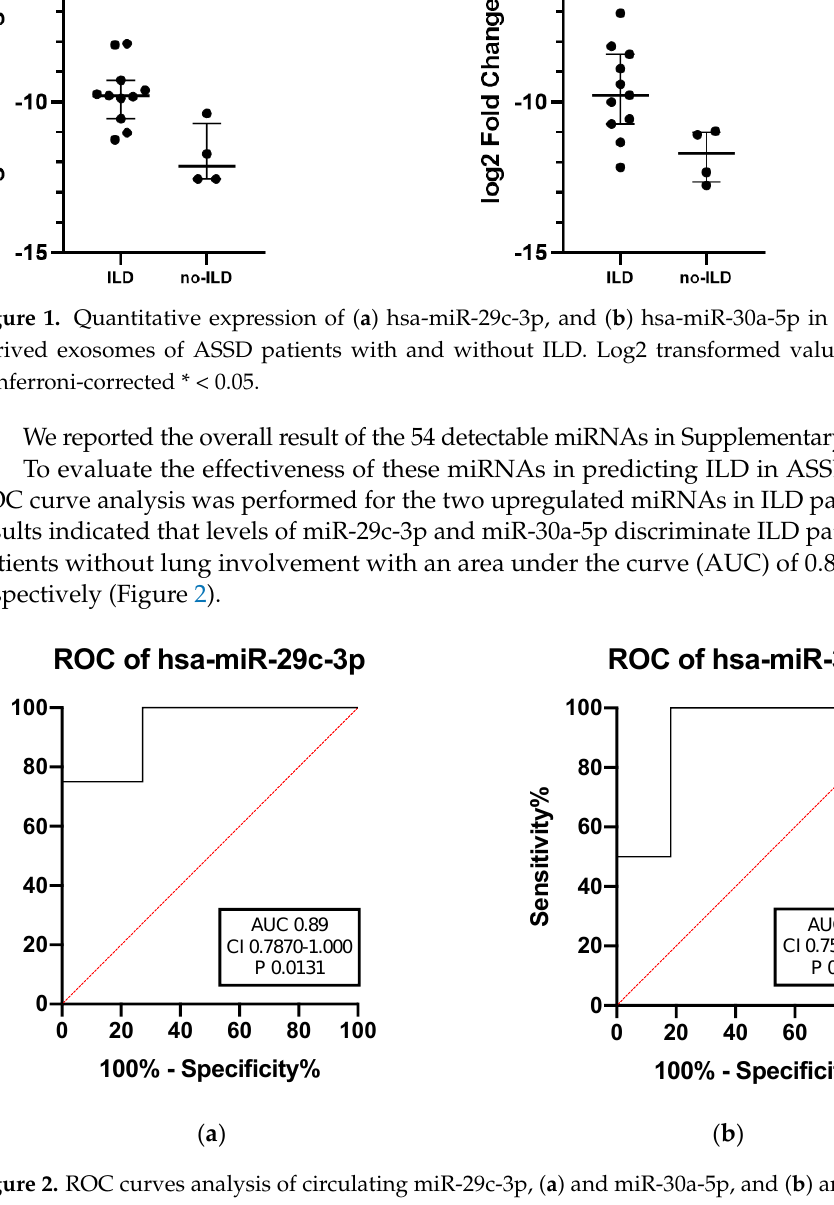
Table 2. Biological pathways enriched by differentially expressed serum miRNAs in ASSD-ILD pa- tients compared to no-ILD patients.